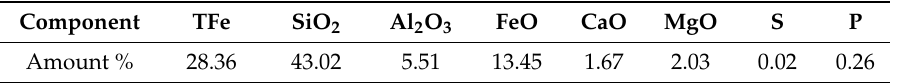
Table 1. Main chemical components of raw ores.